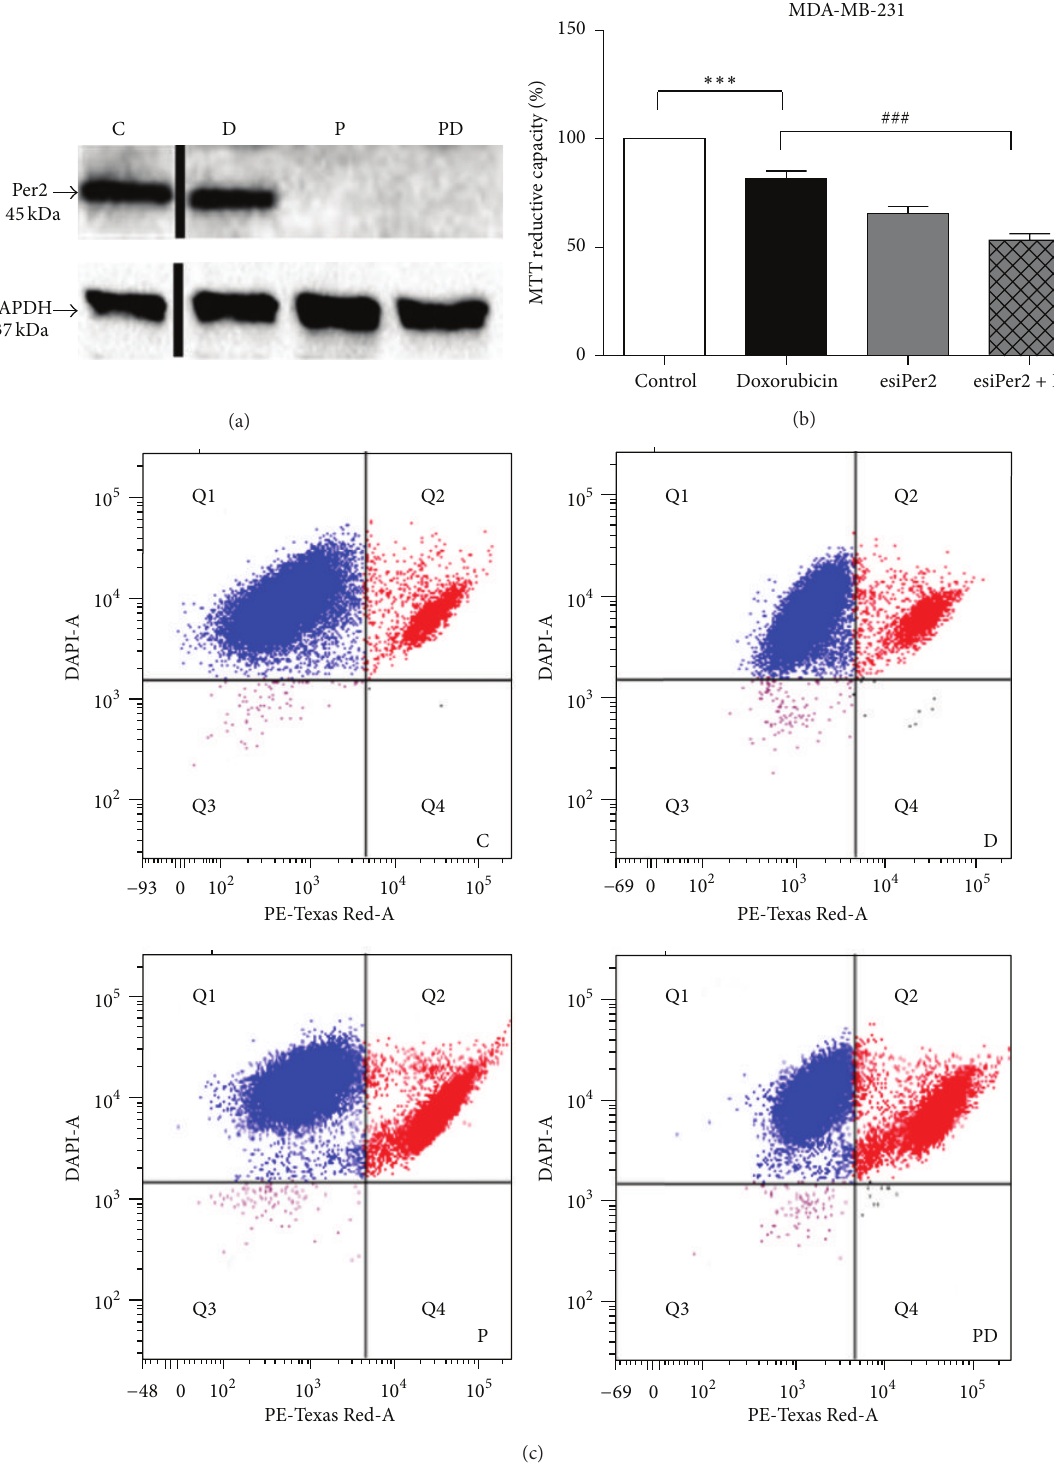
Figure 4: Determining the effects of Per2 silencing on doxorubicin-induced cell death in the ER − MDA-MB-231 breast cancer cells. MDA- MB-231 cells were subjected to (1) control conditions (C), (2) 2.5 𝜇 M doxorubicin (D), (3) 30 nM Per2 esiRNA (P), and (4) 30 nM Per2 for 48 hours + 2.5 𝜇 M doxorubicin for 24 hours (PD). (a) Representative western blots of Per2 protein expression in the MDA-MB-231 cancer cells following treatments. (b) Cell viability was assessed using the MTT assay. Values are expressed as a percentage of the control and presented as mean ± SEM ( 𝑛 = 3 ). ∗ ∗ ∗ = 𝑃 < 0.0001 versus control and ### = 𝑃 < 0.0001 versus doxorubicin. (c) Representative flow cytometry box plots of the MDA-MB-231 breast cancer cells obtained by Hoechst 33342 and propidium iodide (PI) staining following treatments. Q1 represents cells staining positive for Hoechst and negative for PI (live cells) and Q2 represents cells staining positive for both Hoechst and PI (dead